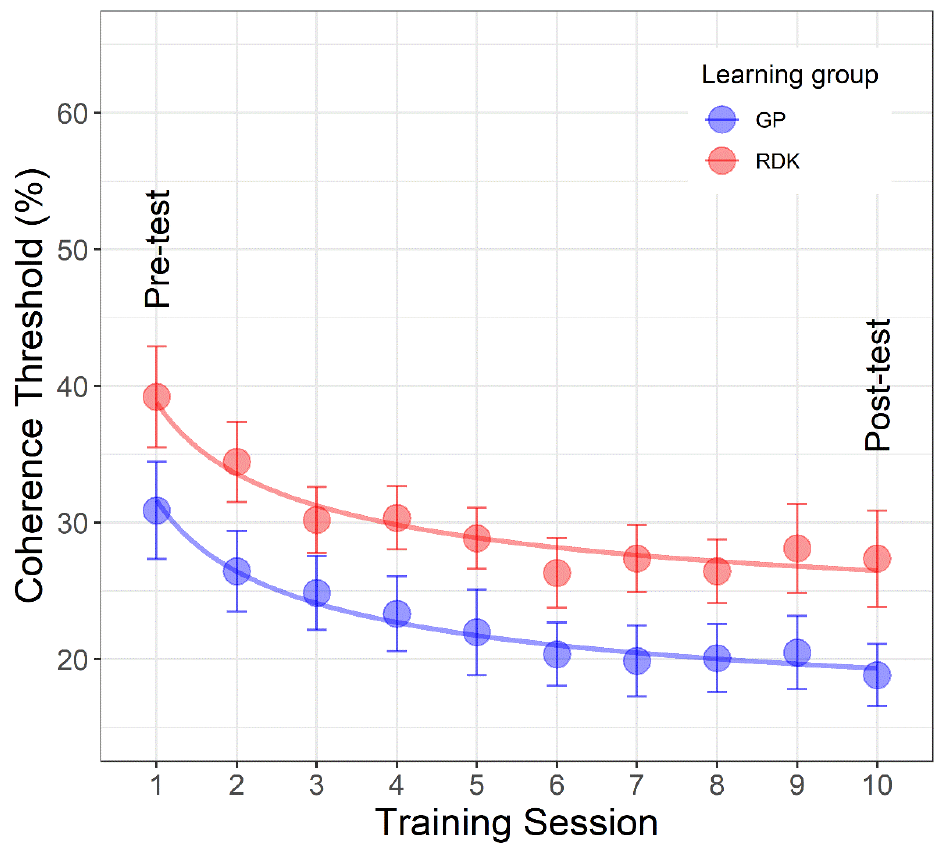
Figure 5. Mean coherence thresholds as a function of learning sessions separately for each learning group. The first point of each curve represents the pre-tests on the same stimulus used during the training, whereas the last point represents the post-test always on the same stimulus used during the training sessions. The dots in blue color represent the data for translational dynamic Glass patterns (GPs) and those in red for the random dot kinematograms (RDKs). The continuous lines represent the best fitting model (i.e., restricted model 4). Error bars ± SEM.